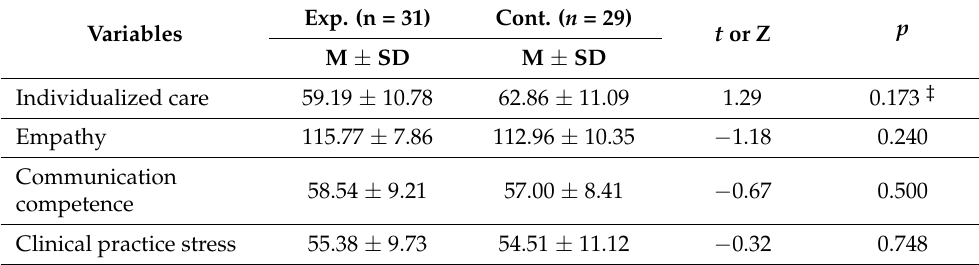
Table 3. Homogeneity test of the dependent variables before intervention (n =